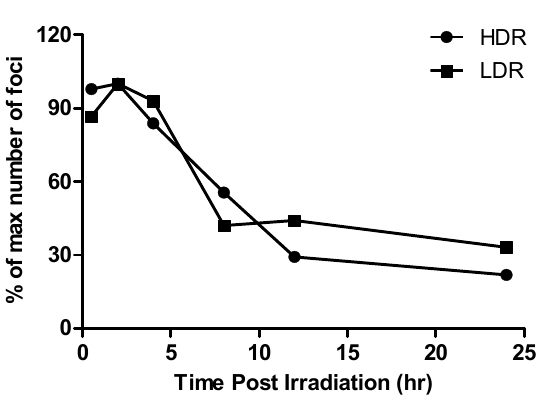
Figure 4. Postirradiation foci numbers were normalised to the maximum number of foci induced at 2 h postirradiation to 1 Gy of HDR (0.400 Gy / min) and LDR (0.015 Gy / min) neutrons. Data represents the mean number of γ -H2AX foci ± standard deviation of two independent experiments.